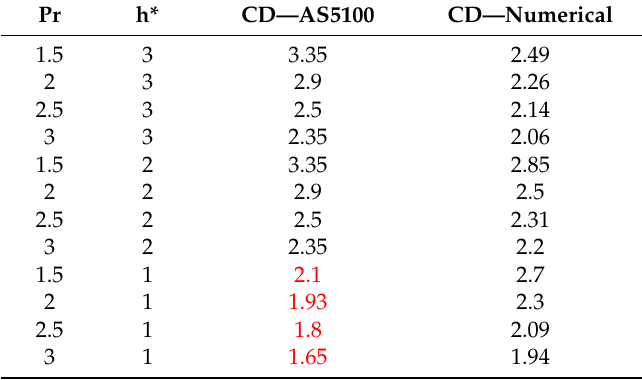
Table 6. Comparison of drag coefficients between AS5100 [7] and this study. Red numbers indicate situations when AS5100 [7] fails to be